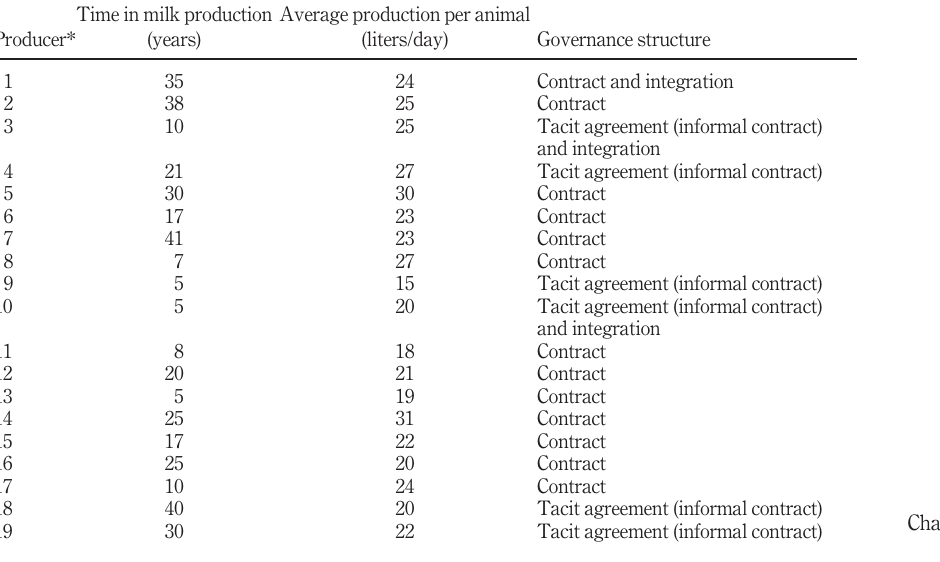
Table 1. Characteristics of